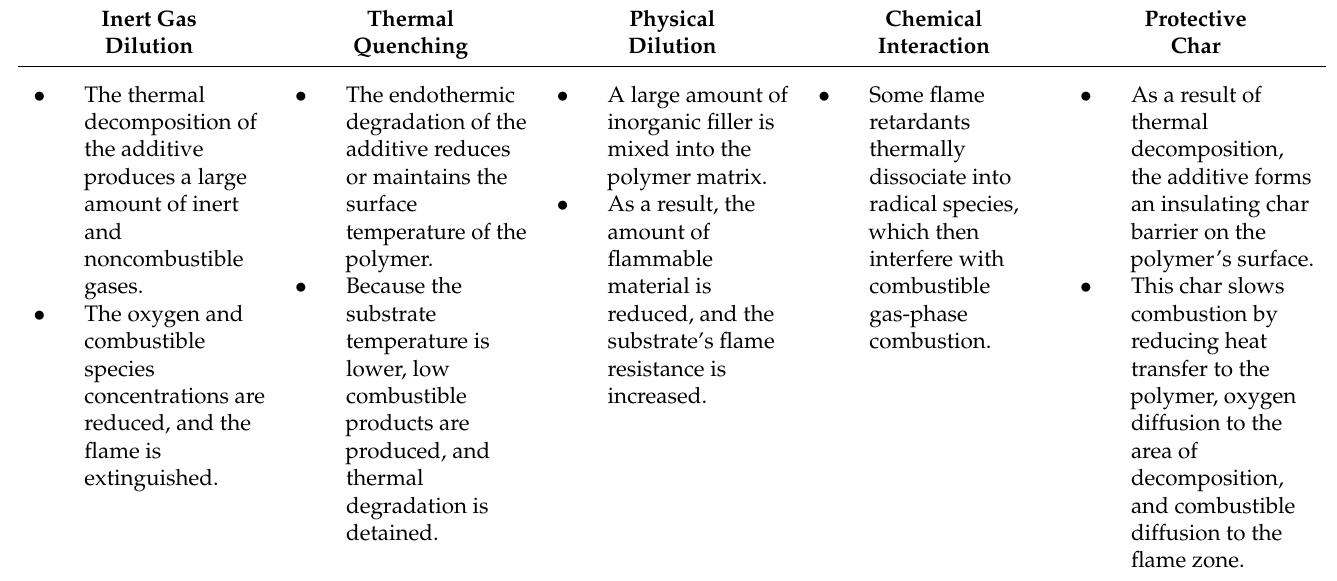
Table 1. The principles of flame retardant systems consist of inert gas dilution [60], thermal quen- ching [61], physical dilution [62], chemical interaction [63,64], and protective char